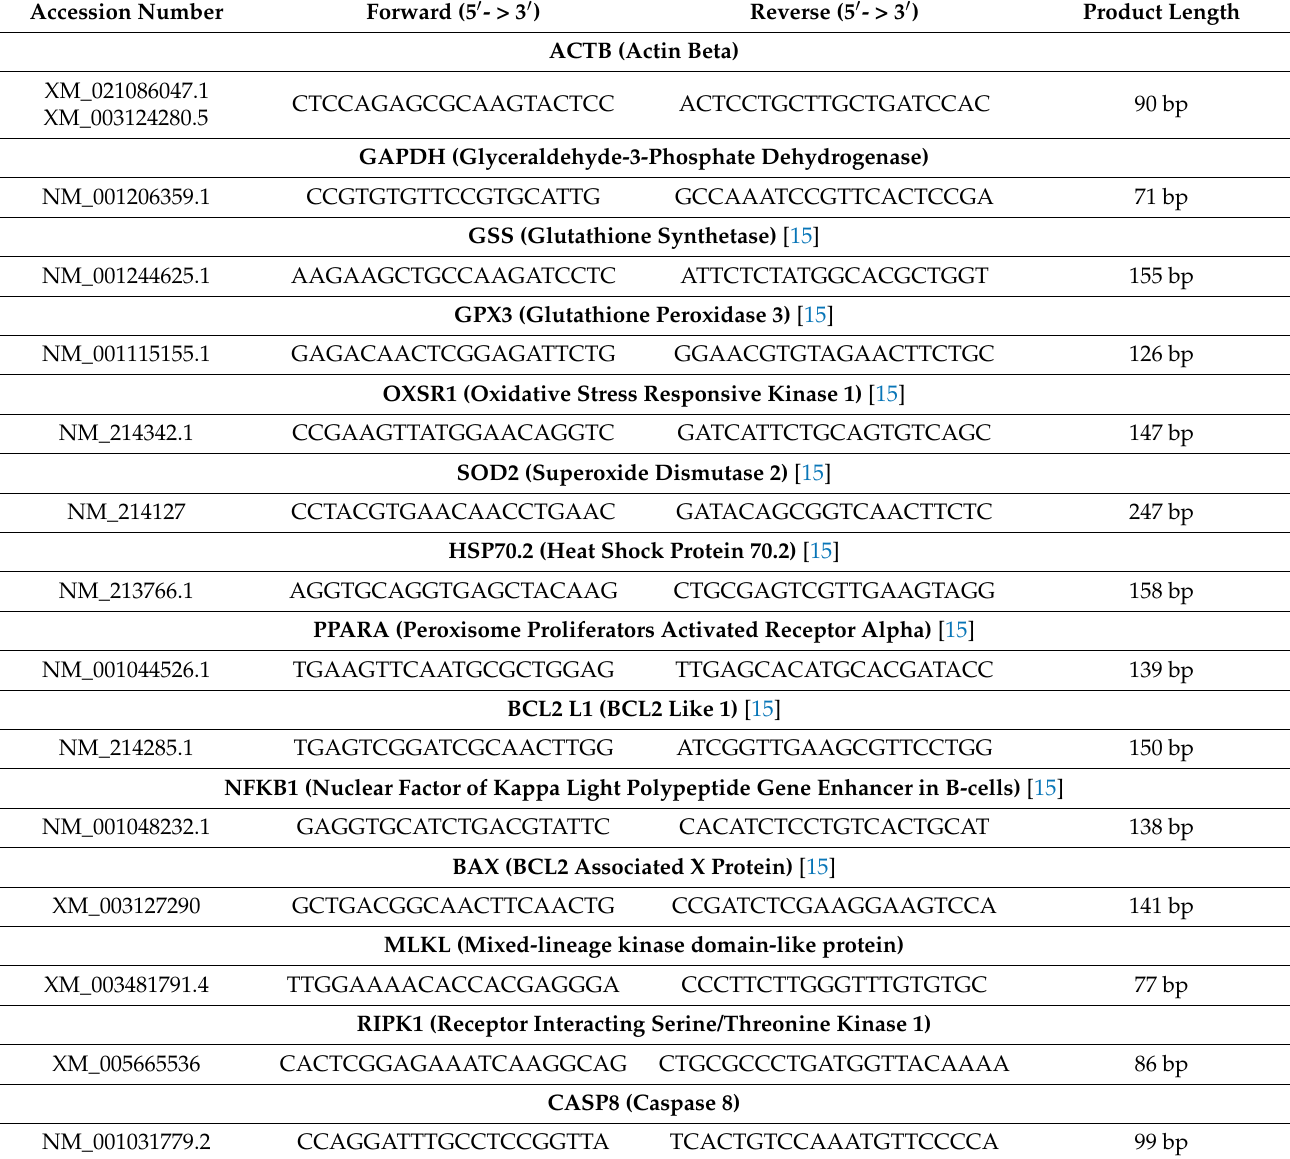
Table 1. Genes used for quantification and primer